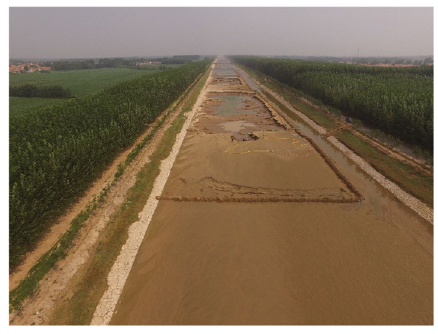
Fig. 5 Sampling site of Yellow River sediments